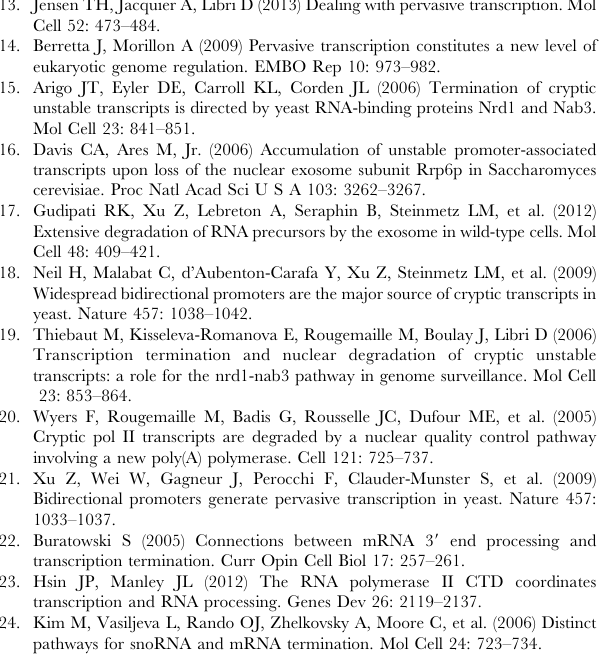
Figure S2 A–D. Replicate pair-wise comparison of number of reads corresponding to each gene in our PAR-CLIP biological replicates. Spearman coefficient is represented by rho. Figure S3 A–C. Pair wise comparison of number of Rpb2-HTP cross-linked reads in each annotated gene vs. GRO-seq reads [54] or NET-seq reads [53]. Spearman coefficient is represented by rho. Figure S4 A–D. Histograms representing normalized reads with Ysh1 (grey) and without Ysh1 (black) at the given genomic locations. Genes and pA sites are represented below each graph and the length of the genome depicted is given in the lower right hand corner. Below are qPCR at different times after addition of rap using the amplicon highlighted in red. Figure S5 Relative position on Schulz et al. termination points compared to our PAR-CLIP determined inflection points. Figure S6 A comparison of NET-Seq data from Churchman and Weissman [53] to our normalized reads at the SNR3 and SNR34 locus. Figure S7 Comparison of PAR-CLIP data to Schulz et. al. 4tU- seq data [65]. Number of reads for each base pair at the given locus is represented by a histogram. Genes and introns are represented under each graph. Figure S8 Histograms representing normalized reads with Sen1 (grey) and without Sen1 (black) at the given genomic locations. Figure S9 Histograms representing normalized reads with Nrd1 (grey) and without Nrd1 (black) for NRD1 and TYE7. The same